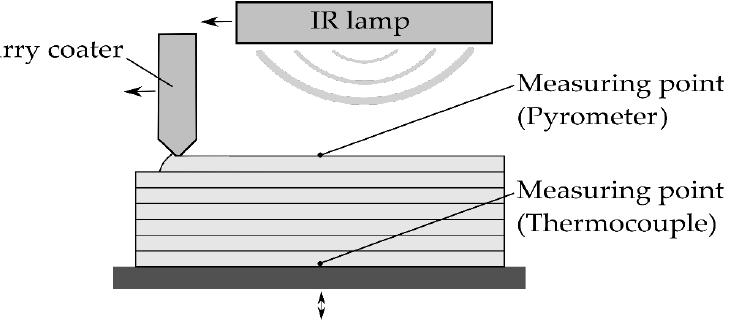
Figure 1. Scheme of the investigated process.